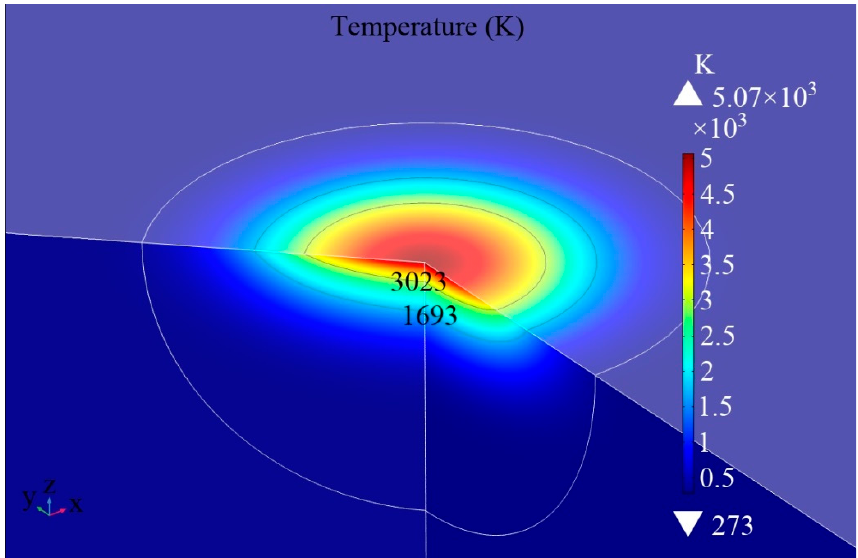
Figure 2. The temperature distribution in micro/nano-EDM without considering the non-Fourier effect.